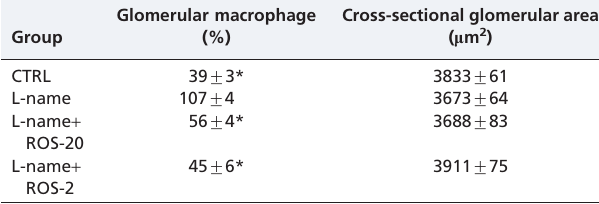
Table 3 - Glomerular macrophage infiltration and the cross-sectional glomerular area of the kidneys of animals at the end of the